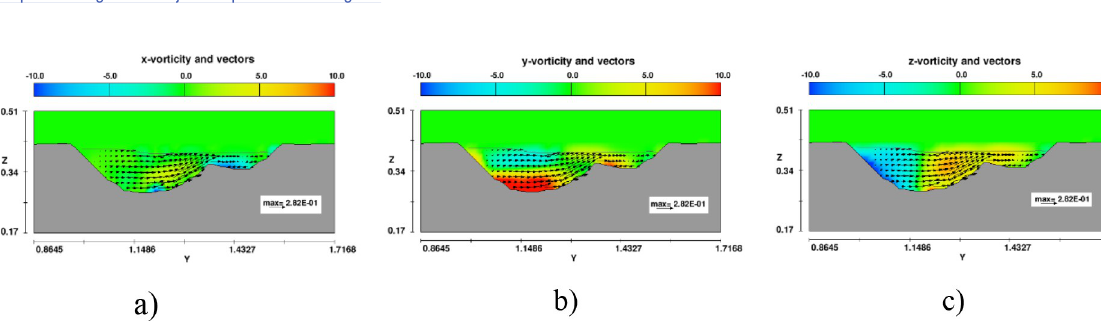
Fig 16. Distribution of vortex components distribution at section 4 in model B. a) x -vorticity; b) y -vorticity; c) z -vorticity.